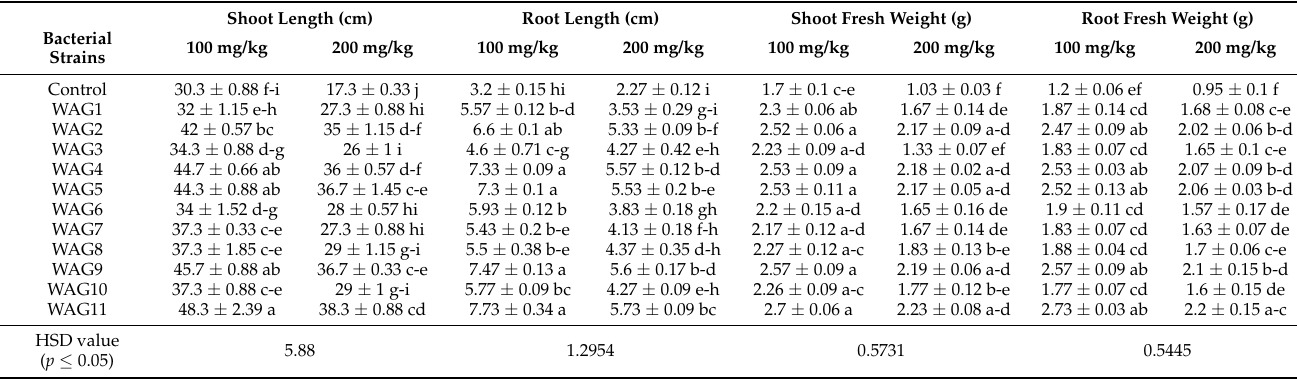
Table 3. Effect of isolated bacterial strains on morphological characteristics of maize plants in glyphosate-spiked